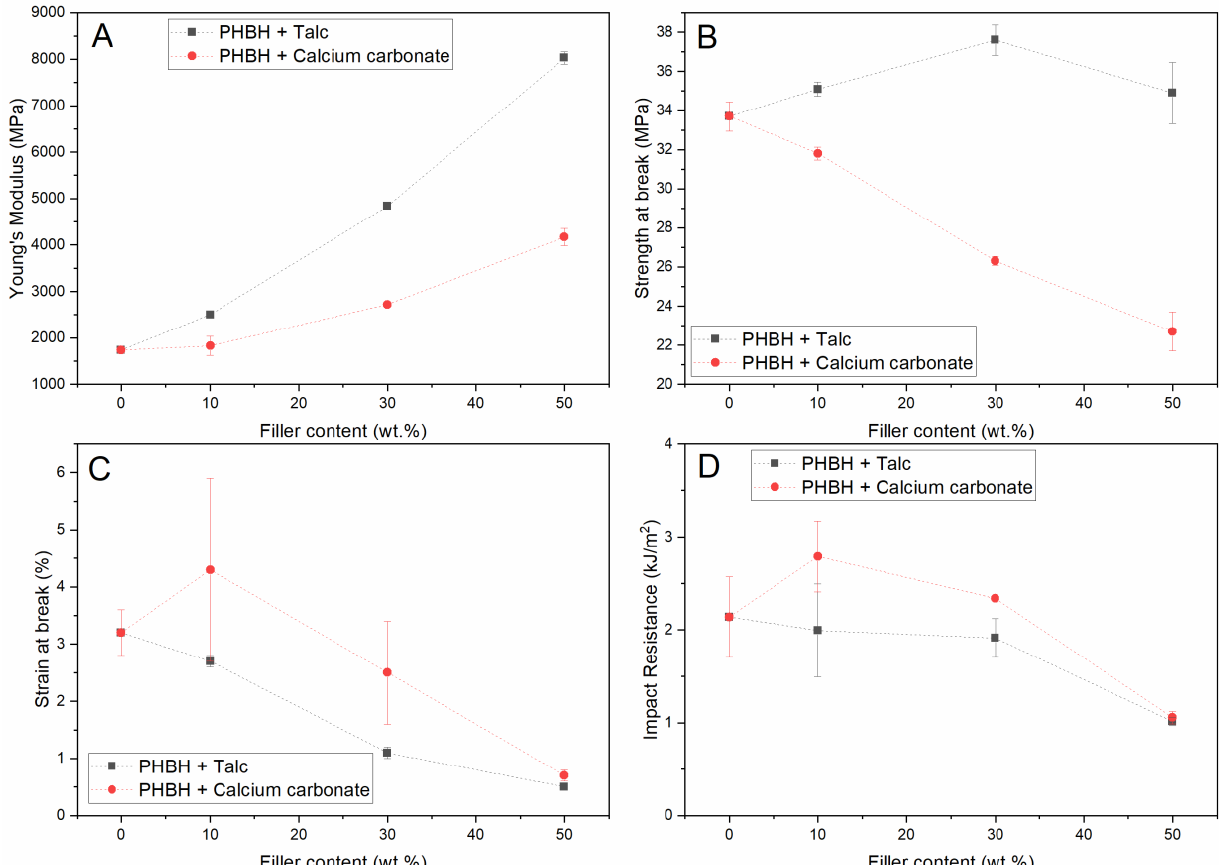
Polymers 2021 , 13 , x FOR PEER REVIEW Figure 3. Mechanical properties (Young’s Modulus ( A ), strength at break ( B ), strain at break ( C ), and notched impact resistance ( D )) of talc and calcium carbonate in PHBH.